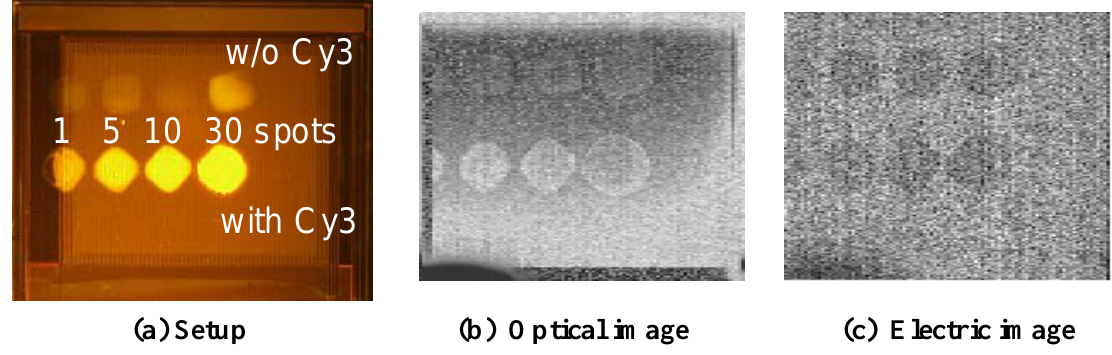
Figure 6. Images of on-chip DNA spots captured with and without illumination (adapted from [3]). ( a ) The setup; ( b ) Optical image; and ( c ) Electric image, of DNA spots with and without Cy3